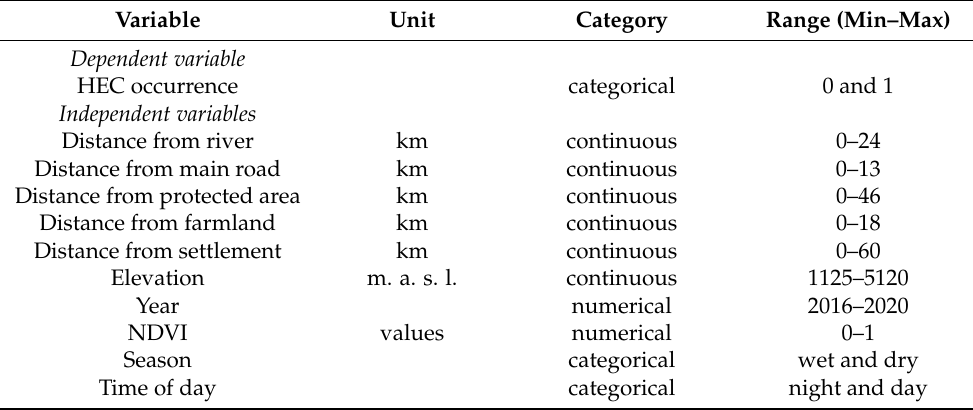
Table 1. Major environmental variables that were used in our model to test whether they influenced human-elephant conflict occurrences were collected in the Enduimet Wildlife Management Area, Tanzania, from 2016 to 2020. NDVI = Normalized Difference Vegetation Index, season = time of the year that is distinguished by special climate condition (wet and dry), HEC = human-elephant conflict.